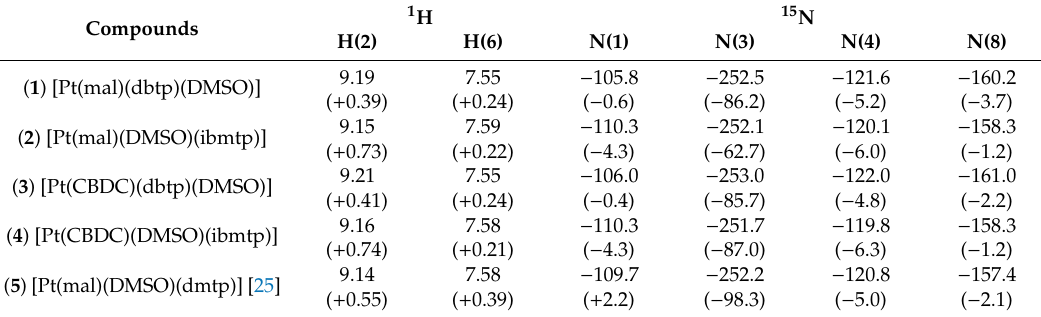
Table 2. 1 H and 15 N NMR chemical shifts ( δ ) of platinum(II) complexes [in ppm]. Compounds